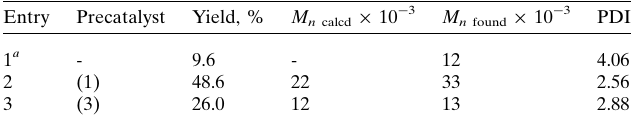
Table 2 Catalytic activity of 1 or 3 in acrylonitrile polymerization. M n and the polydispersity index (PDI) were determined from size-exclusion chromatography (SEC) measurements.